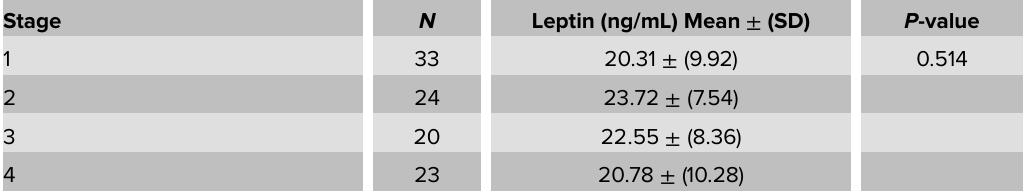
Table 3: Mean values of leptin concentration in different stages of BC.